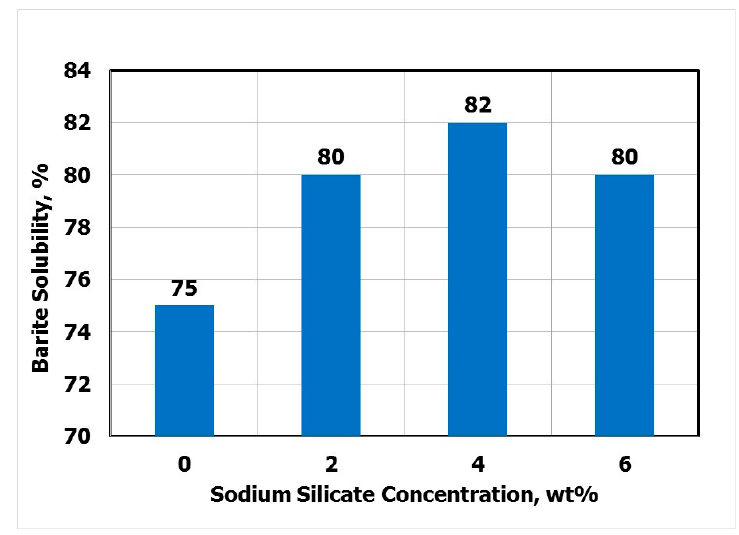
Figure 5. Effect of adding sodium silicate on barite solubility at 200 °F.